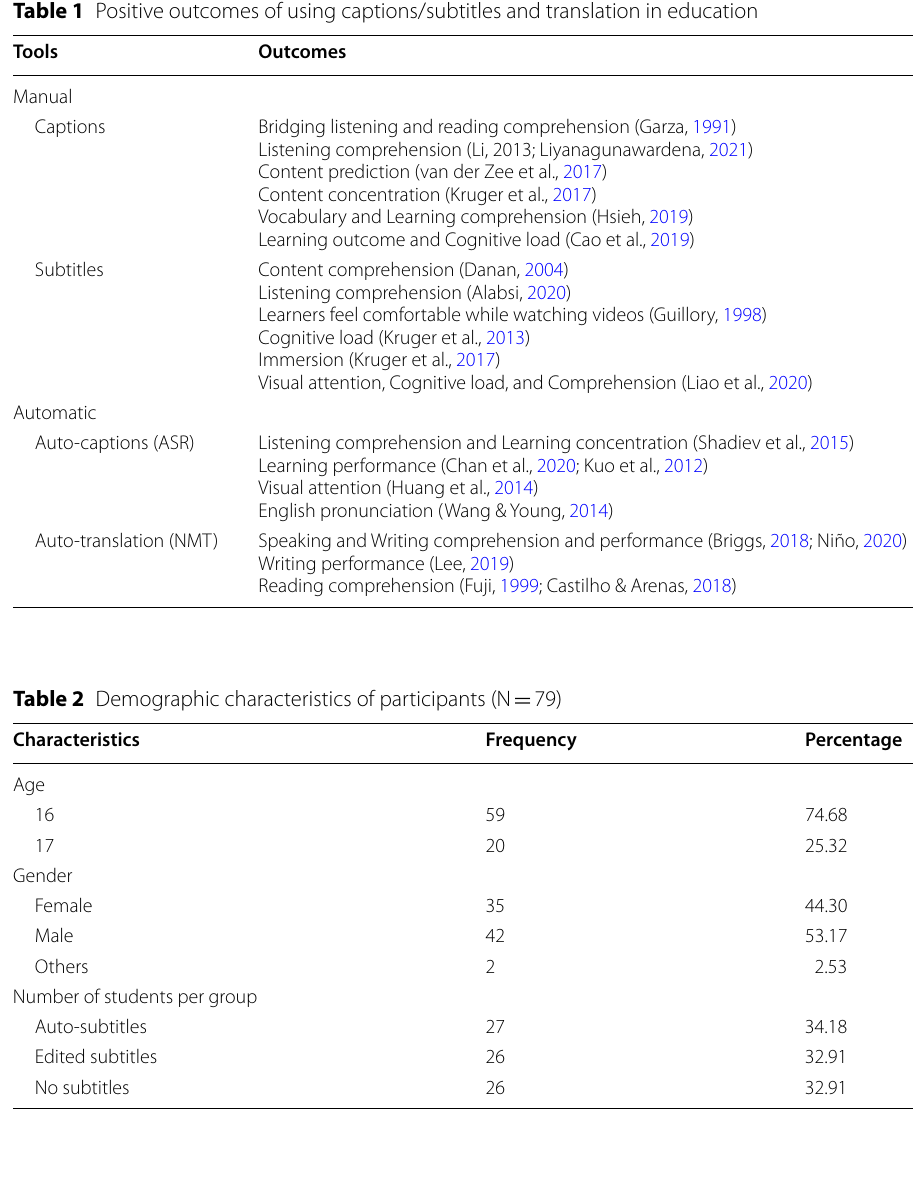
Table 1 Positive outcomes of using captions/subtitles and translation in education Tools